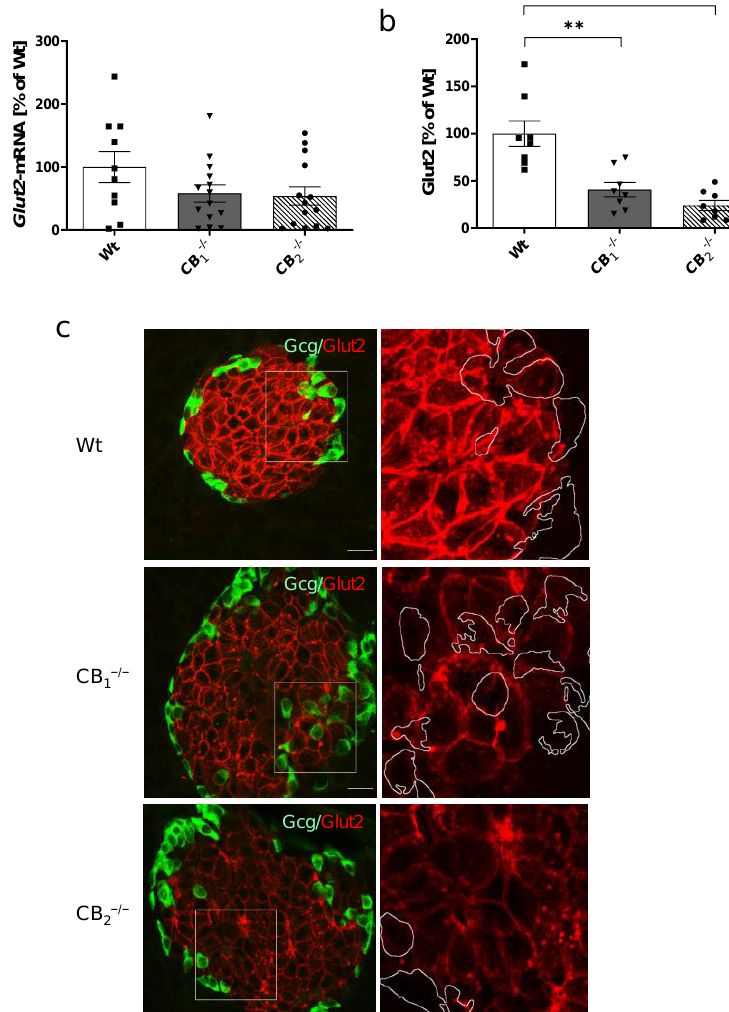
Figure 6. Analysis of glucose transporter 2 mRNA ( Glut2 ) and protein (Glut2) in pancreatic tissue of male and female wild-type (Wt) mice and cannabinoid receptor knockout mouse lines (CB 1 − / − , CB 2 − / − ). ( a ) Relative mRNA expression level of Glut2 was decreased in both knockout mouse lines ( n = 10 – 14). ( b ) In addition, protein content of Glut2 was also decreased in CB 1 − / − and CB 2 − / − mice ( n = 8). ( c ) Immunohistochemical staining of Glut2 (red) and colabelling of glucagon (Gcg, green) was shown to be prominent in the pancreatic islet displaying a typical membrane-concentrated distribution pattern in beta-cells. As shown in the overview (left column), as well as in the magnification of each islet (2.5 fold, box) on the right column, knockout mice yielded weaker Glut2 immunostaining of the membranes in beta-cells, but also increased cytoplasmic accumulations, showing stronger accentuation in CB 2 − / − mice. In all cases, confocal optical sections were merged and are representative for pancreatic islets analysed in the whole pancreatic tissue from three mice per group. Values are presented as mean ( ± S.E.M.) and Wt values were defined as 100%. ** p < 0.01; *** p < 0.001; unpaired t -test. Scale bar 20 µm.